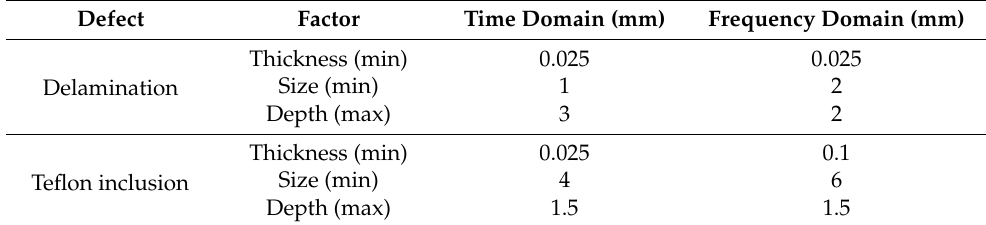
Table 1. Imaging performance of the THz tomography